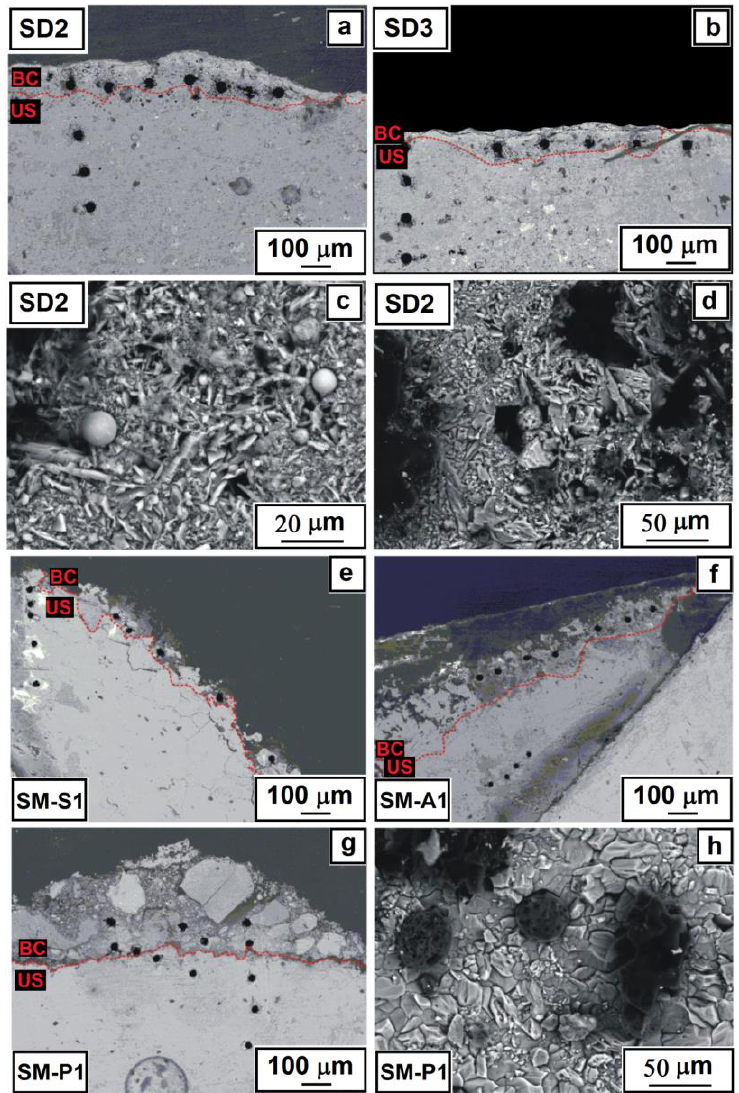
Figure 4. SEM microphotographs of some examined samples (i.e., SD2, SD3, SM-S1, SM-A1 and SM-P1) with details of combustion particles and gypsum crystals ( c , d , h ). The holes caused by LA-ICP-MS spot analyses (carried out on black crusts = BC and unaltered substrates = US) are also visible ( a , b , e , f , g ). The red dotted line demarcates the layer of black crust from the substrate. Elemental analyses were carried out by EDS on the black crust to evaluate the chemical composition in terms of major elements, as well as their distribution within the sample (i.e., black crust).